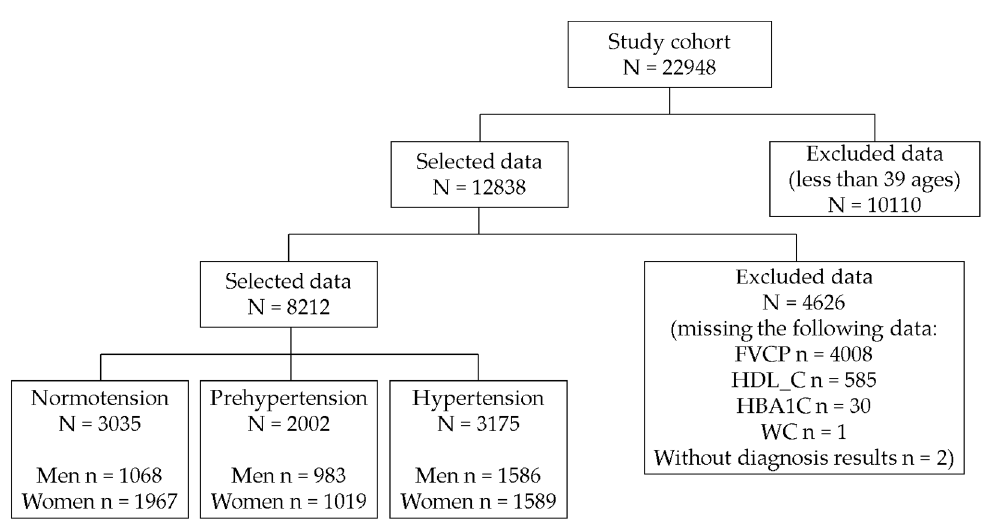
Figure 1. Sample selection procedure.